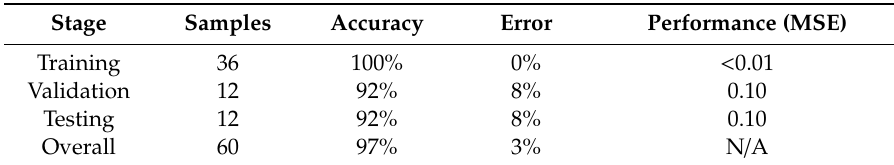
Table 4. Statistical data from the pattern recognition artificial neural network Model 1 classify beers into the type of fermentation (top, bottom, and spontaneous) using the electronic nose outputs as inputs. The performance was based on means squared error (MSE).